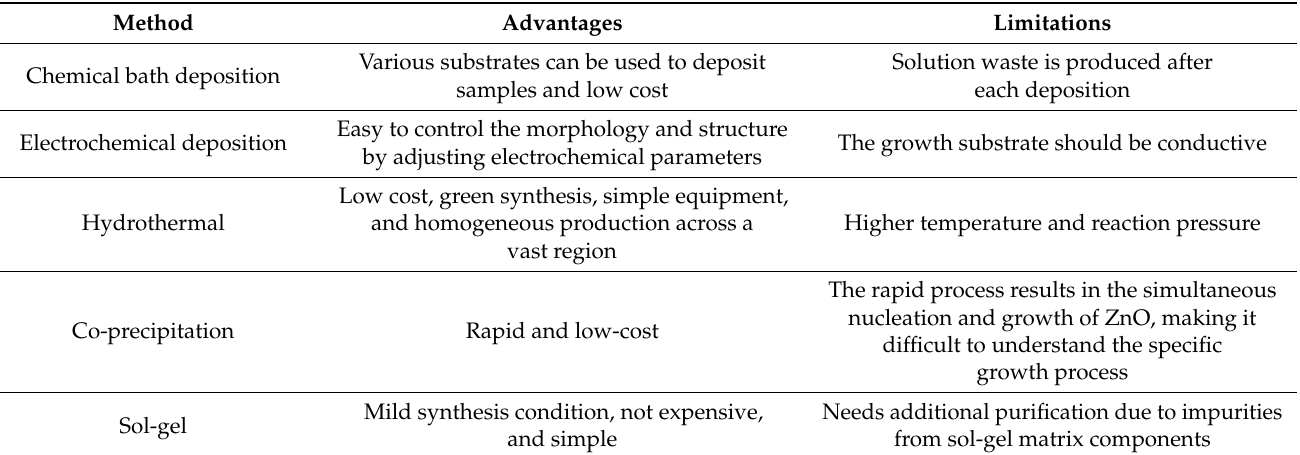
Table 1. The comparison of solution-based approaches for the synthesis of 3D-ZnO